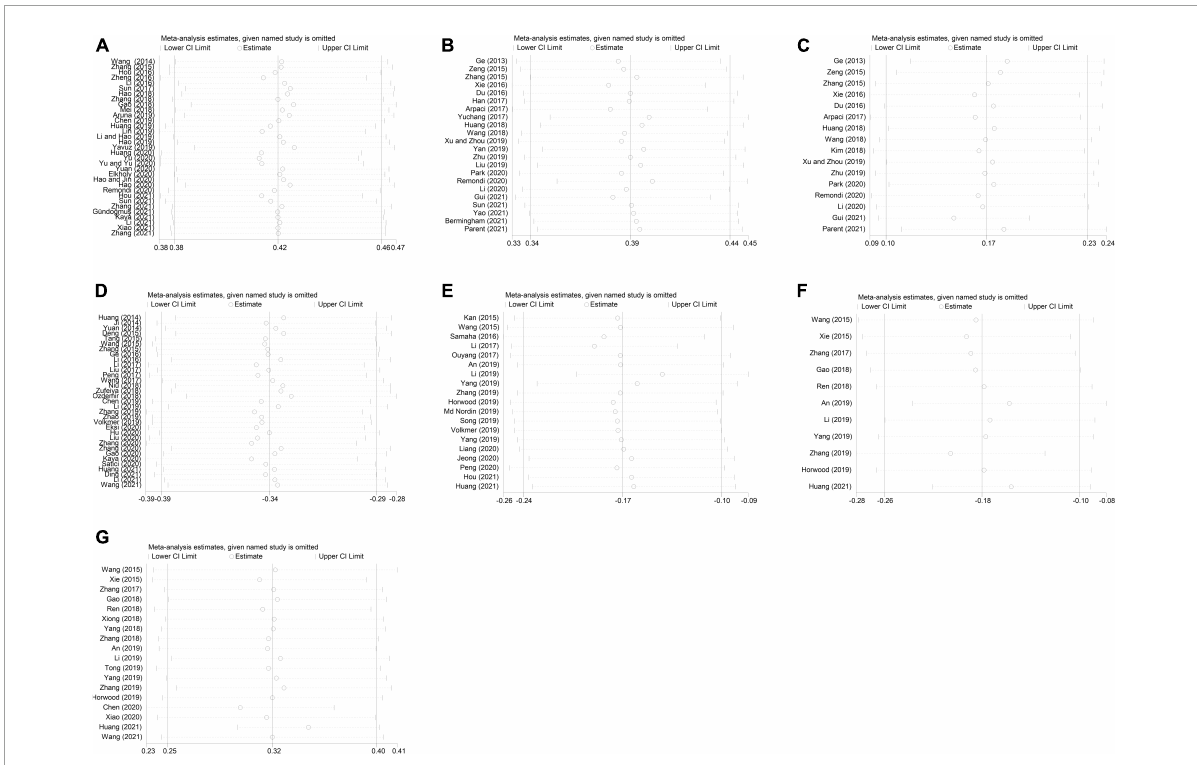
FIGURE3 Sensitivity analysis of the correlation between mobile phone addiction and (A) alexithymia, (B) attachment anxiety, (C) attachment avoidance, (D) subjective well-being, (E) life satisfaction, (F) positive emotion, (G) negative emotion. Reproduced with permission from Stata